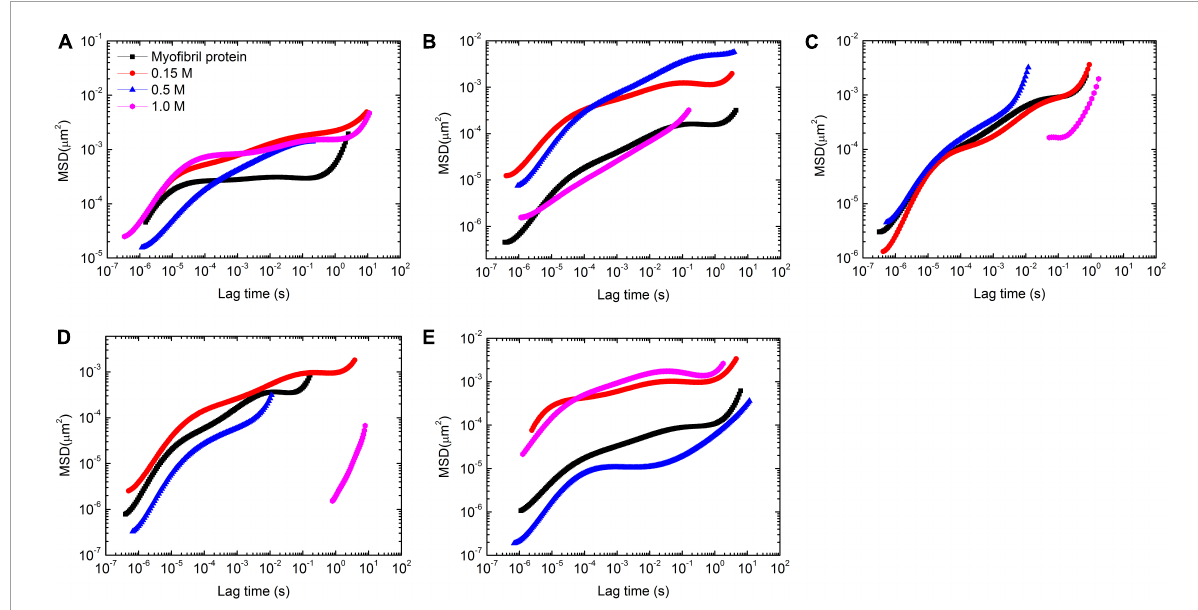
FIGURE4 Mean-square displacement (MSD) vs. temperature with 4 concentrations of KCl (0, 0.15, 0.5, and 1 mol/L) at 5 temperatures [25 (A) , 30 (B) , 35 (C) , 40 (D) , and 45 ◦ C (E) ] in myofibrillar protein (5.6 mg/ml) gelation process.